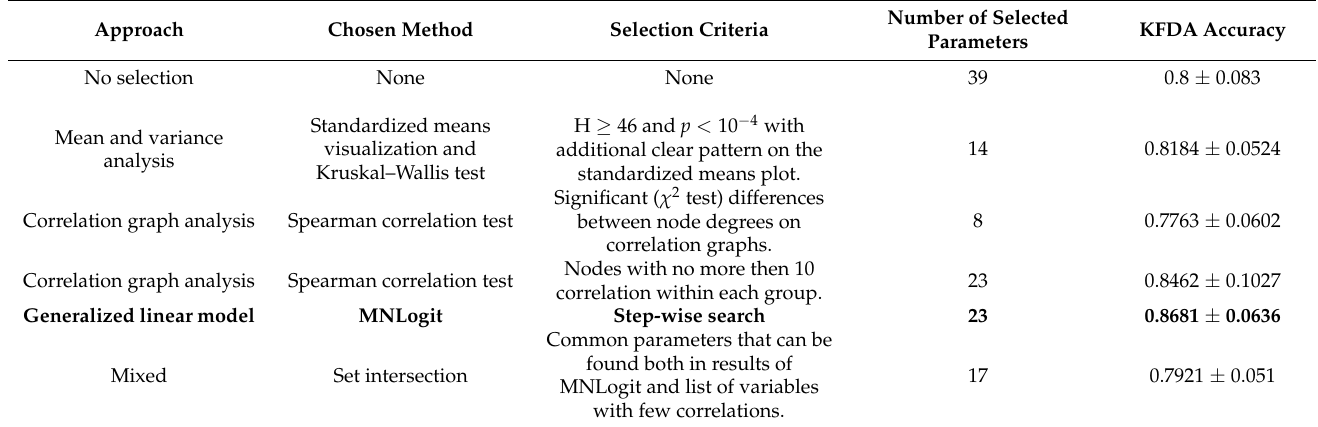
Table 5. Comparison of different approaches for feature selection based on evaluated mean accuracy of the KFDA model. Additional information about a number of chosen parameters, selection criteria, and methods used is given in distinct columns. The best feature selection method was highlighted with bold text.